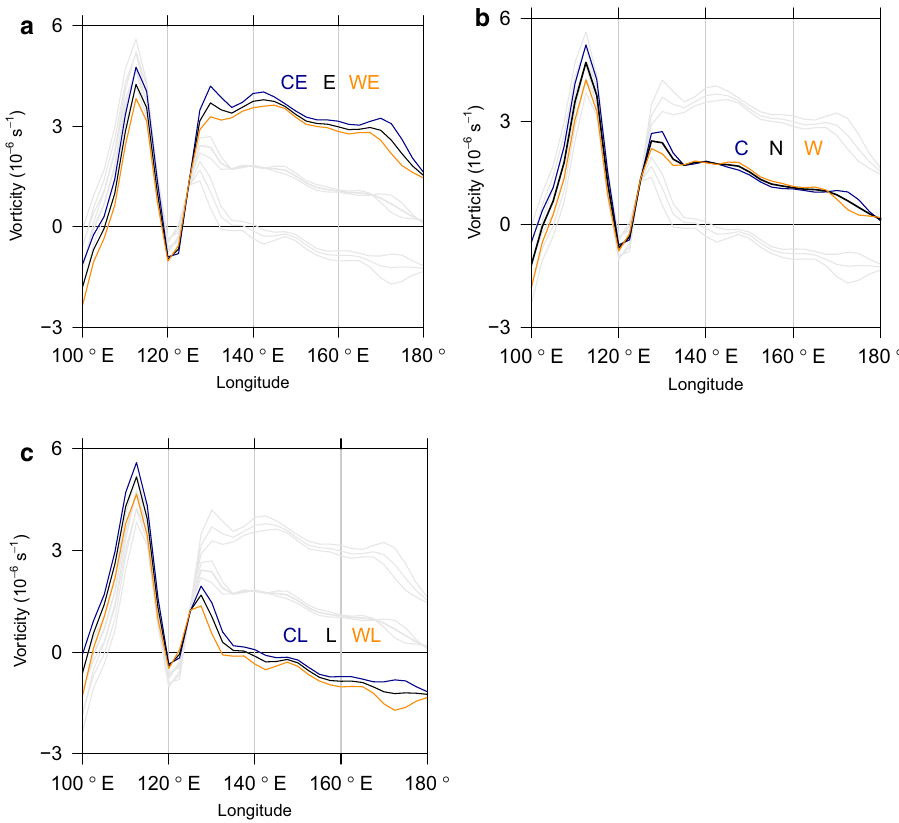
Figure 4. Longitudinal distribution of vorticity. The local vorticities between 5 ◦ –20 ◦ N are averaged along 100 ◦ E–180 ◦ for ( a ) “El Niño mode (E) and its anomaly modes (CE, WE)”, ( b ) “Colder mode and Warmer mode (C, W)” around Nomral (N), and ( c ) “La Niña mode and its anomaly modes (CL, WL)”. The black lines from top to bottom represent E, N, and L, and the blue and red lines in each panel show the colder and the warmer anomalies,